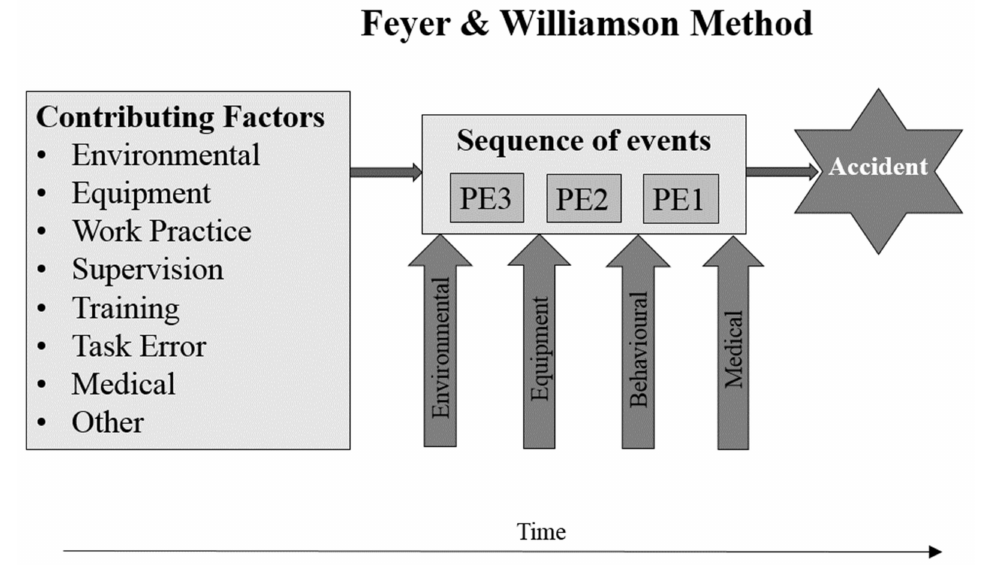
Figure 3. Elements that compose the Feyer and Williamson method. PE1, PE2, and PE3 are Precursor